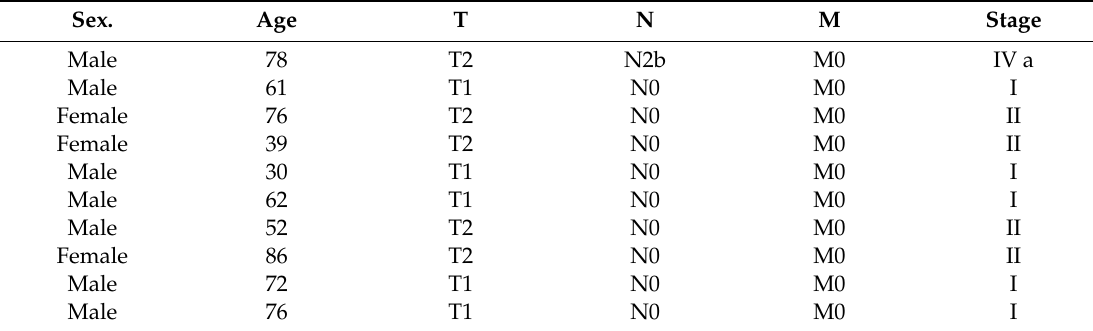
Table 1. List of patient-derived